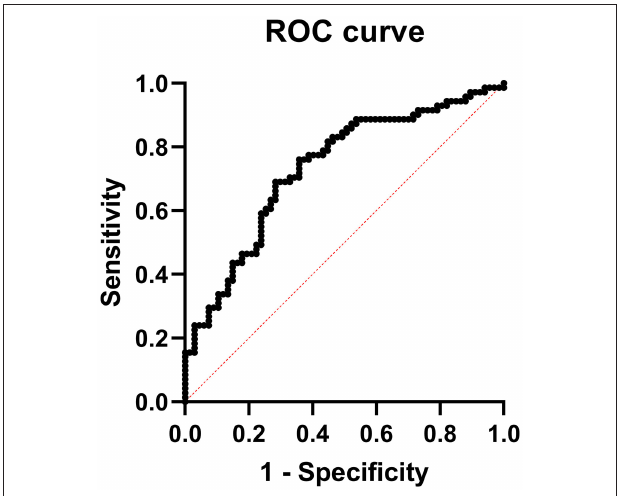
FIGURE 1 | Receiver operating characteristic (ROC) curve analysis of prediction model for fertility > 52% after AI with refrigerated ram seminal doses.